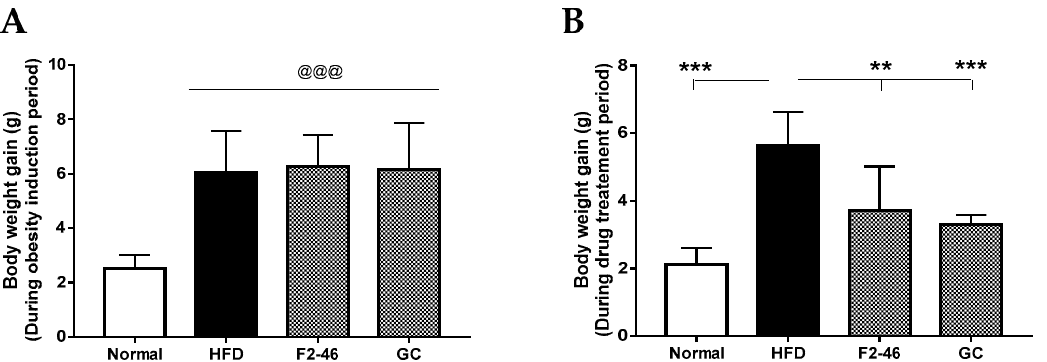
Figure 3. Effects of F2 on body weight gain. Mouse body weight was measured every week. Mice were fed with only HFD or standard diet for 5 weeks of the obesity induction period. Obesity was successfully developed in the HFD fed groups in 5-weeks. The obese mice were then treated with F2, GC, or vehicles (0.2% CMC/PBS) for another 7 weeks. The body weight gains ( A ) during the 5 weeks of the obesity induction period and ( B ) during the 7 weeks of drug treatment period are presented separately. Values are expressed as the mean ± SD (n = 5 to 6). A one-way ANOVA was applied to calculate statistical significance. @@@ p < 0.001 vs. Normal; ** p < 0.01; and *** p < 0.001 vs. HFD control. Normal = standard diet; HFD = high-fat diet control; F2-46 = F2 (46 mg/kg); GC = G. cambogia (200 Table 4. Diet-induced obesity and controlling of weight gain by F2 in obese mice.